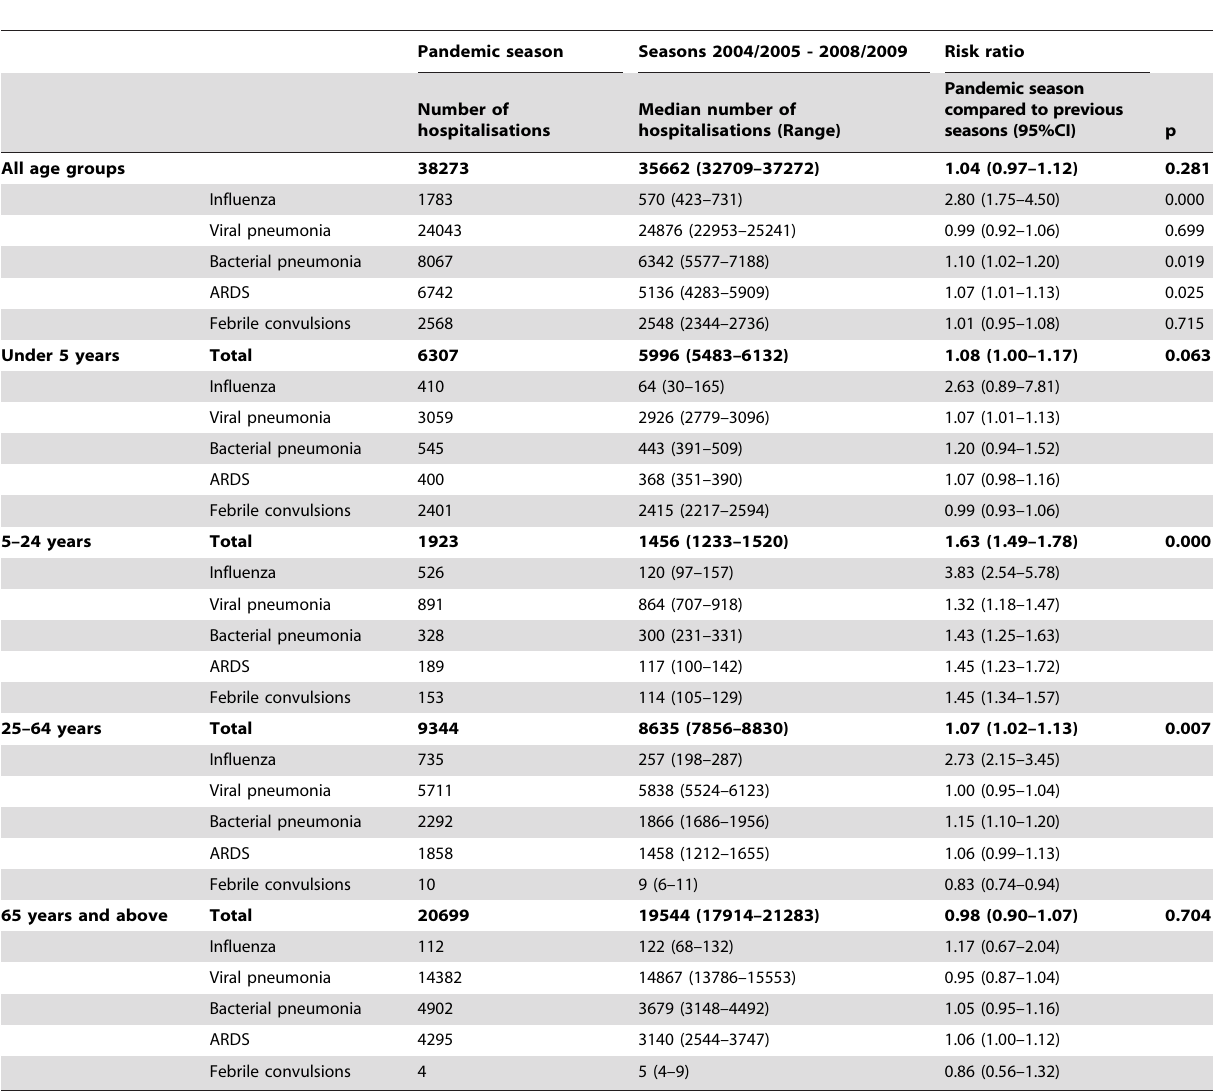
Table 1. Total numbers of influenza-associated hospitalisations in Denmark, seasons 2004/2005–2009/2010, by age groups and diagnostic